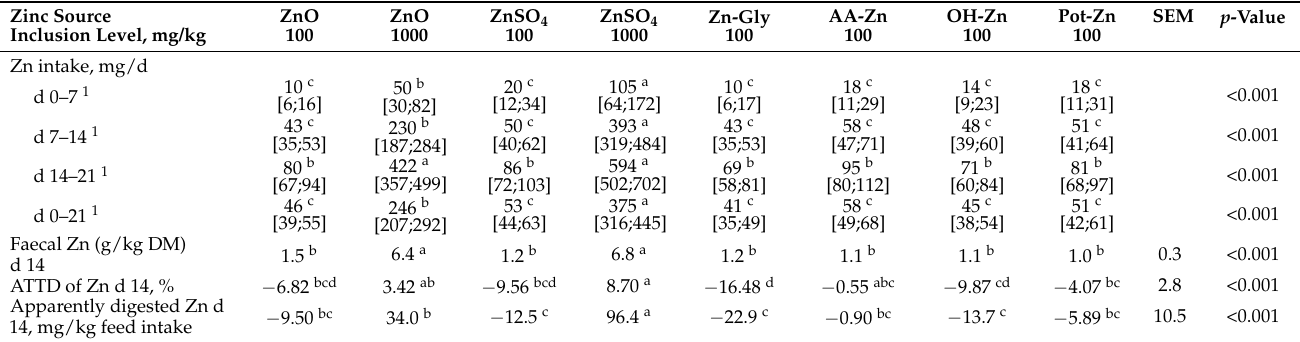
a,b,c,d Means within a row with different letters are significantly different ( p < 0.05). 1 Presented as the least square (LS) means ± 95% confidence intervals due to logarithmic transformation of